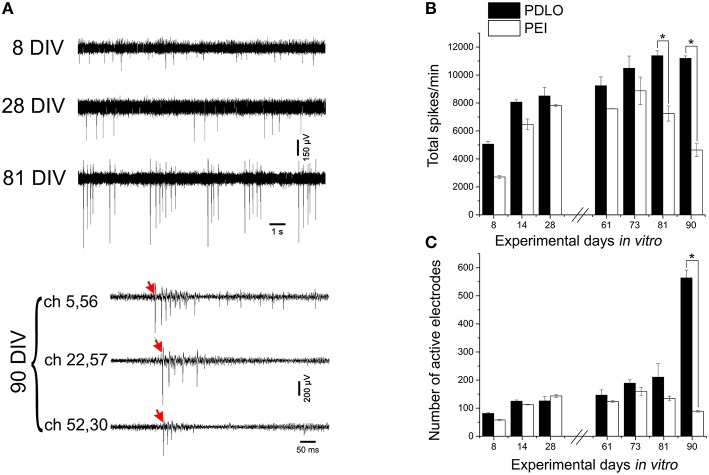
High-resolution electrical read-outs with CMOS-MEAs unveil changes in spiking activity of iCell neuronal networks during development. (A)Typically recorded extracellular signal traces associated with the detected firing rates during development. The activity develops from single spikes (8 DIV), tonic firing (28 DIV) to bursting, and synchronized spikes (81, and 90 DIV). Red arrows indicate start of propagating burst. (B) Bar graph showing the effect of surface functionalization on the evolution of network-wide spiking activity, i.e., total spontaneous spikes, per 10 min recording phases. Spontaneous firing rates of cultures grown on PDLO coated substrates tend to gradually increase during development to reach a peak at 81 DIV, followed by a plateau at 91 DIV. A similar initial trend (lower rate) is observed for cultures grown on PEI coated substrates cultures, with a peak at 73 DIV (earlier than PDLO cultures). Afterward, firing activity significantly declines at 81, and 90 DIV (n = 3 for each substrate, *p < 0.05, one-way ANOVA). Significant differences of firing activity measures between substrate (PDLO vs. PEI) and DIV (8, 14, 28, 61, 73, 81, and 90) were determined by two-way ANOVA followed by Tukey's post-hoc test (*p < 0.05). (C) Bar graph illustrating the dynamic changes in the total number of active electrodes over 3 months of culture, on PDLO and PEI coated substrates. Consistently with the development of the spiking activity shown in (B), the number of active electrodes indicates an increasing tendency. A higher increase is observed for cultures grown on PDLO than PEI and this tendency becomes significantly higher for cultures on PDLO at 81, and 90 DIV (n = 3 for each substrate, *p < 0.05, one-way ANOVA). Significant differences of detected active electrodes between substrate (PDLO vs. PEI) and DIV (8, 14, 28, 61, 73, 81, and 90) were determined by two-way ANOVA followed by Tukey's post-hoc test (*p < 0.05).